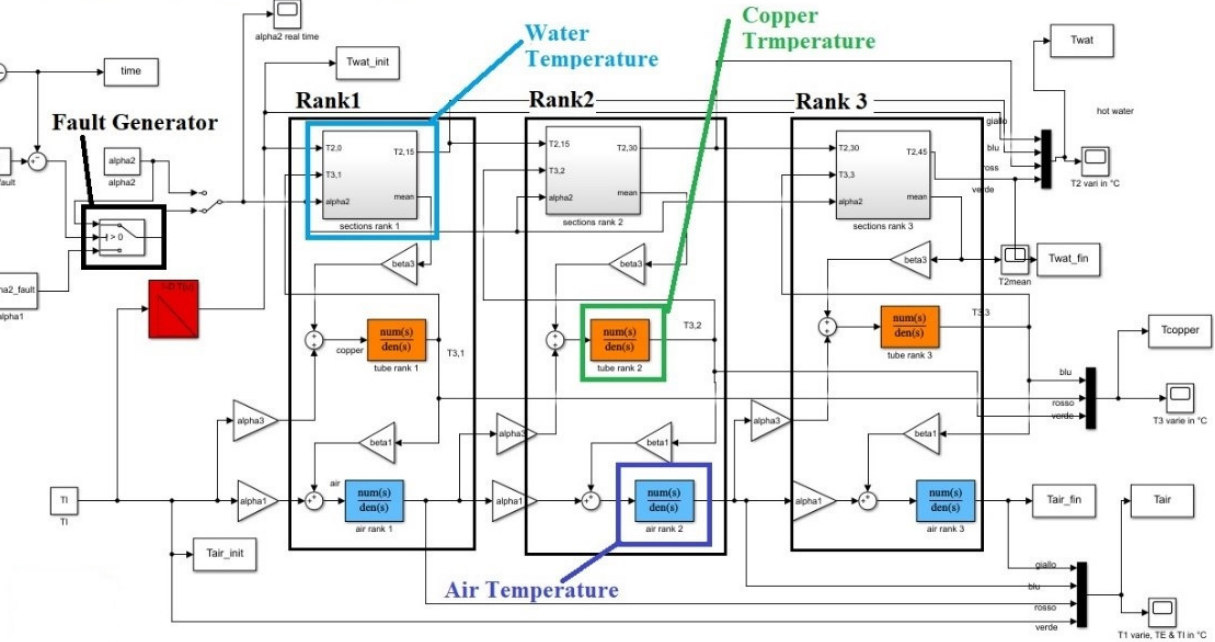
Figure 5. Sketch of the complete Simulink model. Different colors represent respectively water (grey), copper (orange) and air (cyan). In Figure 5, it is possible to observe the Simulink blocks by which the whole model of the heat exchanger is composed, for a heat exchanger equipped with three ranks. In the picture, it is possible to observe: •